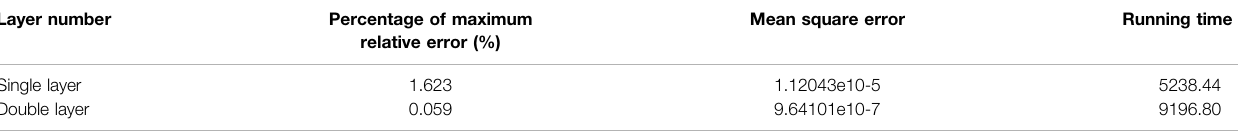
TABLE 2 | Prediction error of BPNN with different hidden layer nodes.